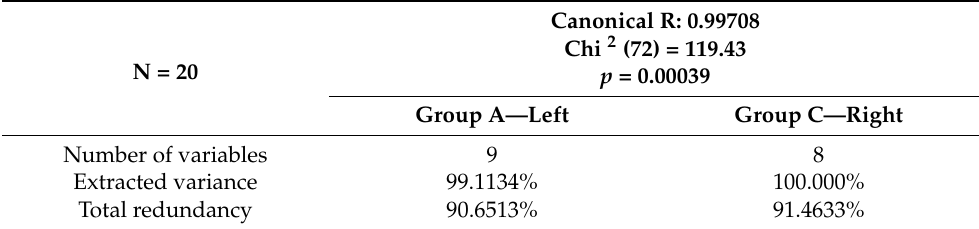
Table 1. Summary of the canonical